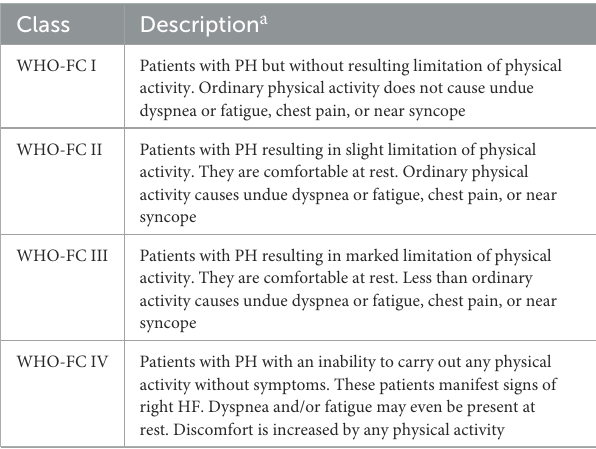
TABLE 5 World Health Organization (WHO) classification of functional status of patients with pulmonary hypertension (11, 33). Class